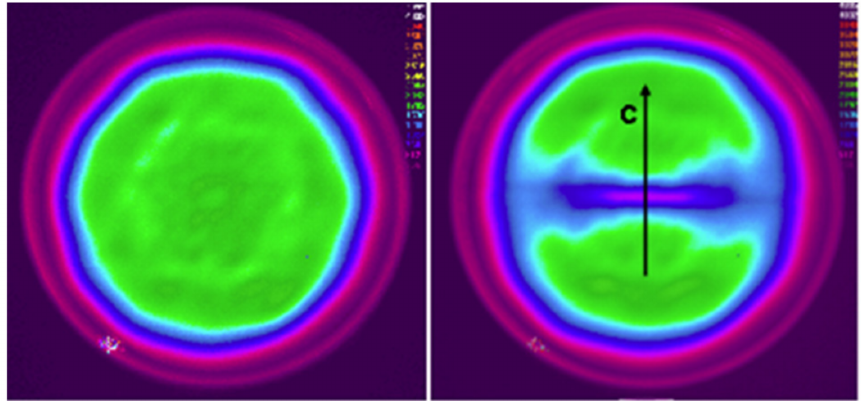
Figure 2. ASE from the pumped Ti:sapphire crystal before and after threshold of parasitic generation